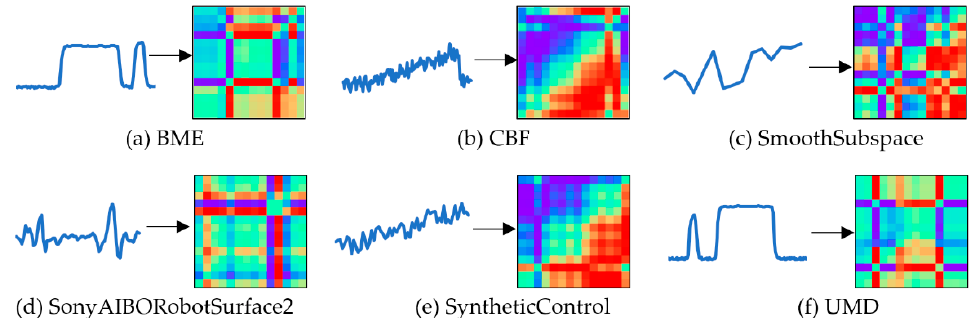
Figure 5. The effect of converting the time-series into GADF images. The GADF images reveal the temporal correlation between data pairs and preserve the spatial variation law intuitively. And the variation in GADF images is roughly the same as that of the abovementioned three image representation methods.